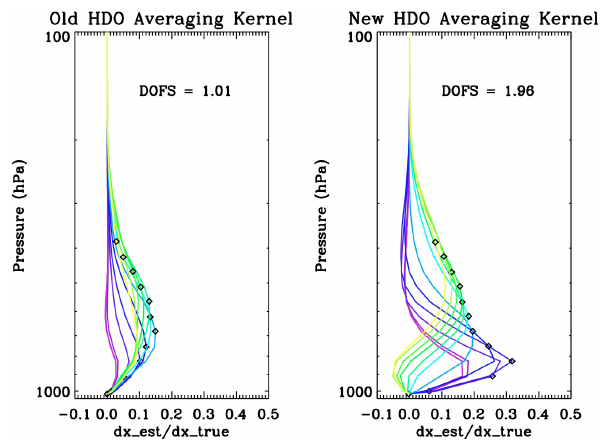
Figure 4a: Averaging kernel for the old and new HDO TES retrievals. As in Figure 2a, the symbols and colors indicate the pressure level and variation with pressure of each row of the averaging kernel matrix.